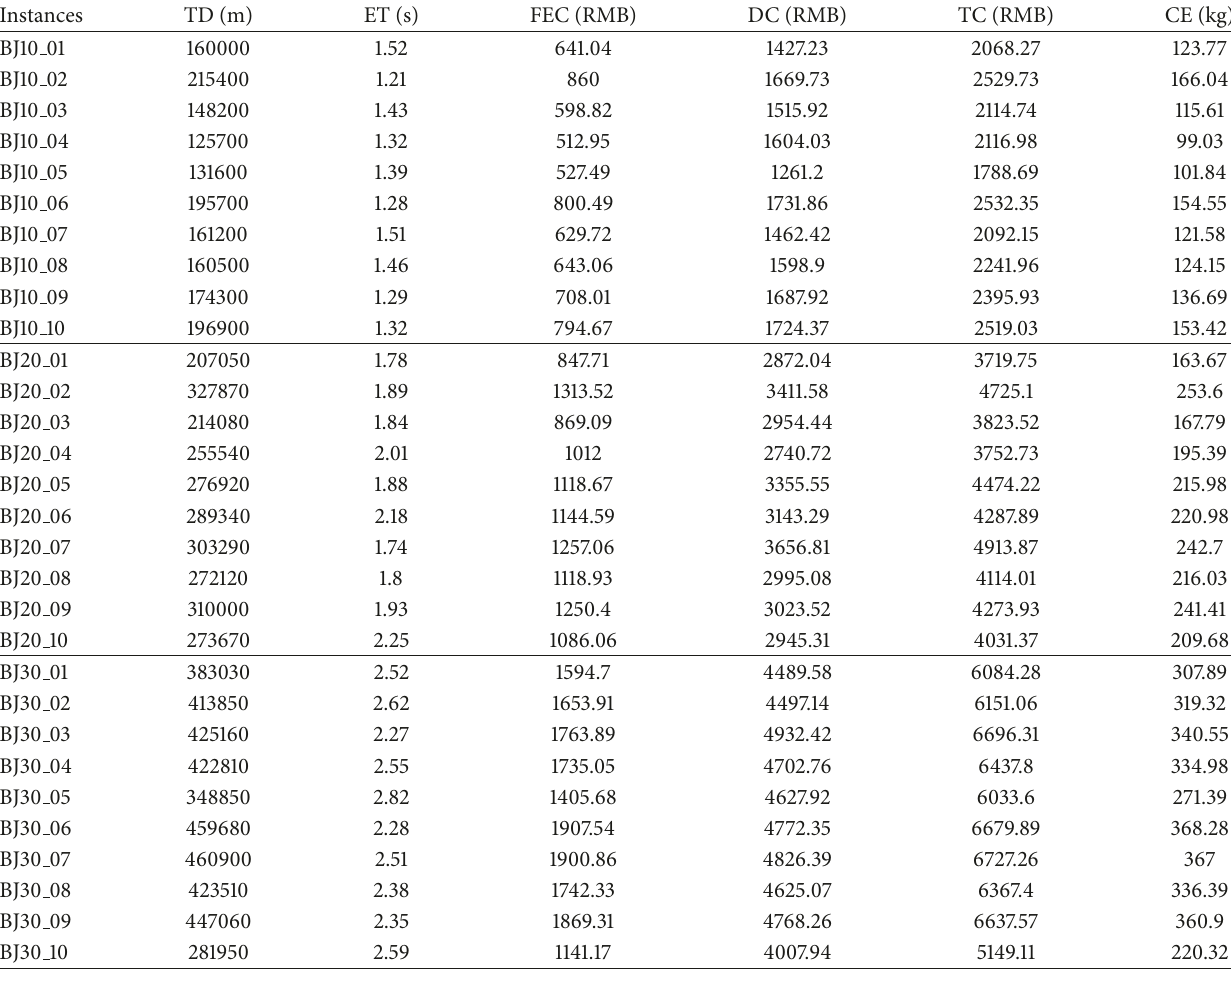
Table 4: Cost components with Min TC.